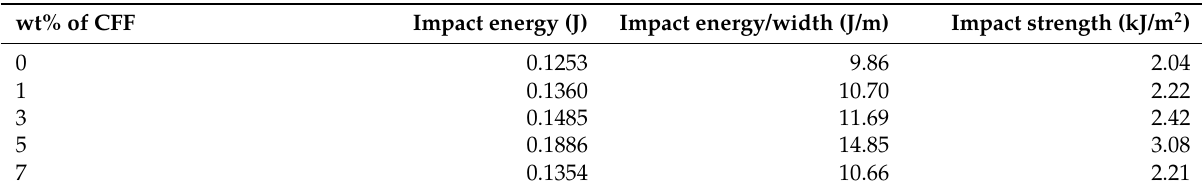
Table 8: Impact strength, impact energy and impact energy/width for various composition of CFF based composite. wt% of CFF